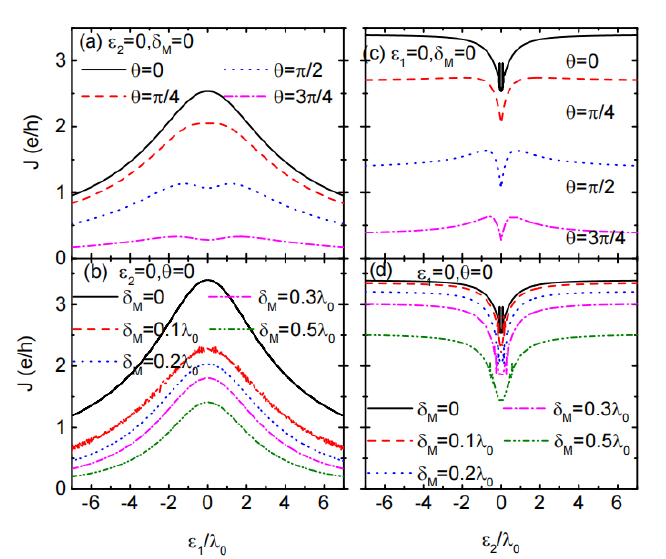
Figure 5. (Color online) Behaviors of the Josephson current as a function of ε 1 in ( a ) for different θ and in ( b ) for different δ M . Similar cases of the current versus ε 2 are given in ( c , d ). Except the parameters shown in the figures, the value of ∆ φ is fixed at π /2.